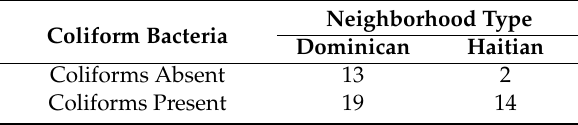
Table 1. Presence of coliform bacteria in water